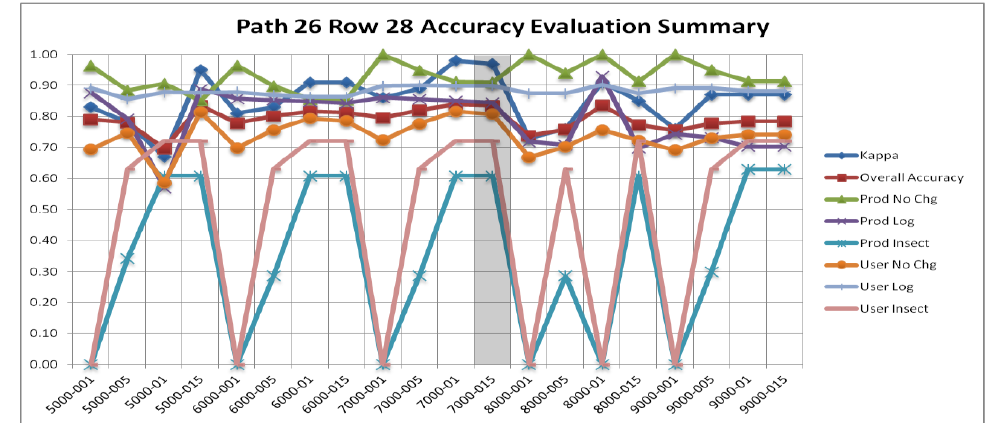
Figure 9. Accuracy evaluation summary results for Path 26, Row 28. Results show iterations of adjusted classification tree splits.